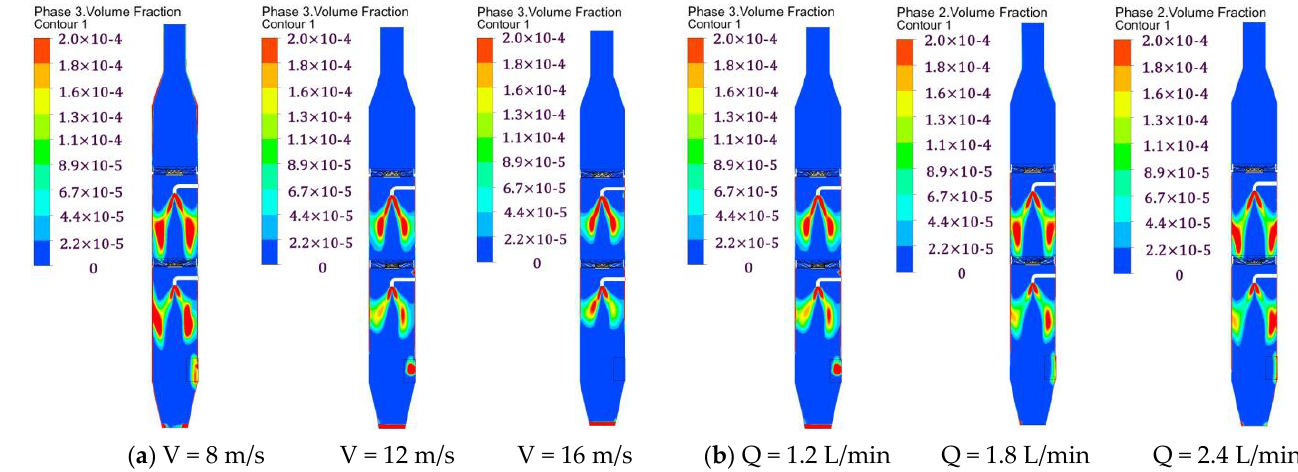
Figure 4. Cloud diagram of the distribution of the volume fraction of the droplets in section Y = 0 for ( a ) different gas velocities and ( b ) different spray volumes